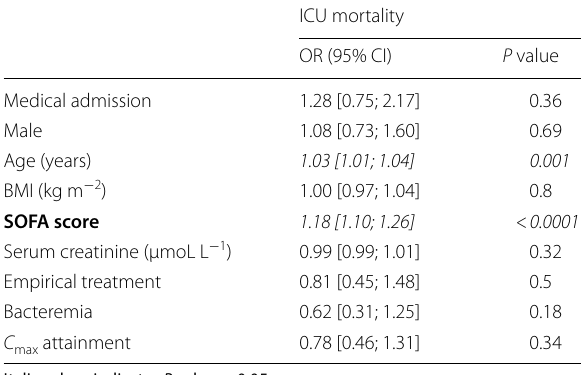
Italic values indicates P values